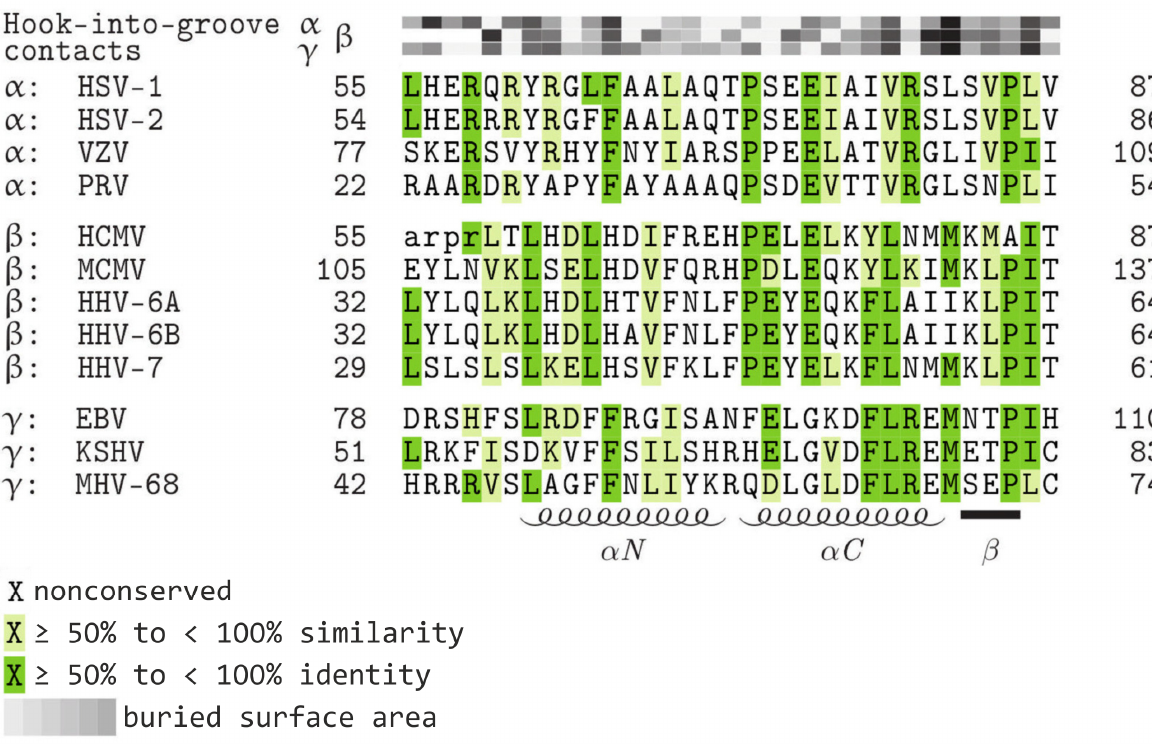
Figure 3. Sequence alignment of homologous hook proteins, highlighting conserved amino acids and amino acids representing contact interfaces. Increasing levels of sequence conservation are indicated by darker shades of green in the alignment. The buried surface area at hook-into-groove contact positions in α -, β -, and γ -herpesviruses is indicated by grey squares. Darker shades of grey indicate a larger buried surface. Lower-case letters mark those residues that were not resolved in the crystal structure (refined illustration referring to [17]). Note, that HCMV pUL53 is the only hook protein with an alanine at position 85, whereas the amino acid proline is conserved at this residue for the other hook proteins. The elements of the secondary structure are depicted schematically below the alignment. HSV-1, herpes simplex virus type 1; HSV-2, herpes simplex virus type 2; VZV, varicella zoster virus; PRV, pseudorabies virus; HCMV, human cytomegalovirus; MCMV, murine cytomegalovirus; HHV-6A, human herpesvirus 6A; HHV-6B, human herpesvirus 6B; HHV-7, human herpesvirus 7; EBV, Epstein-Barr virus; KSHV, Kaposi’s sarcoma-associated herpesvirus; MHV-68, murine herpesvirus